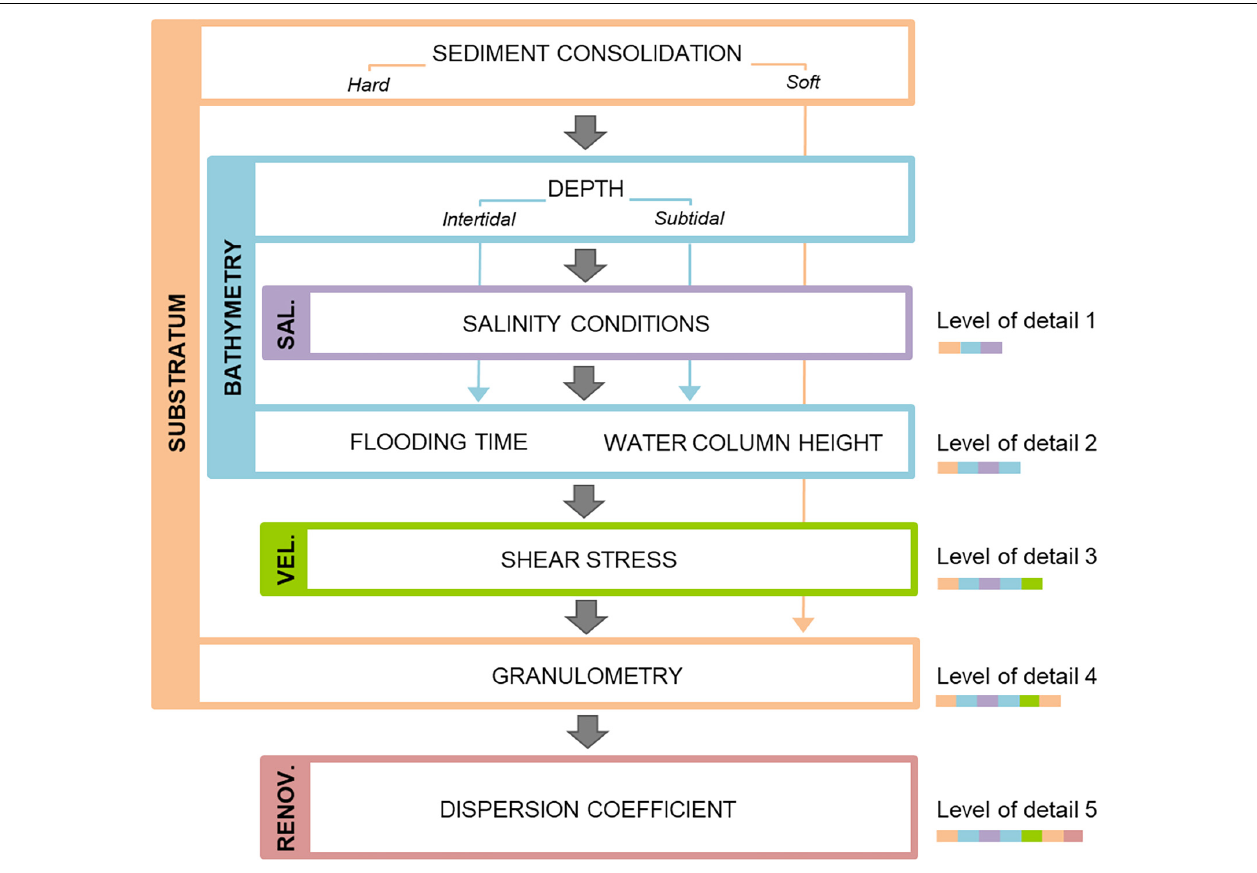
FIGURE 3 | Scheme of the hierarchical integration of abiotic variables and subvariables to obtain the estuarine physiotopes at five scales or levels of